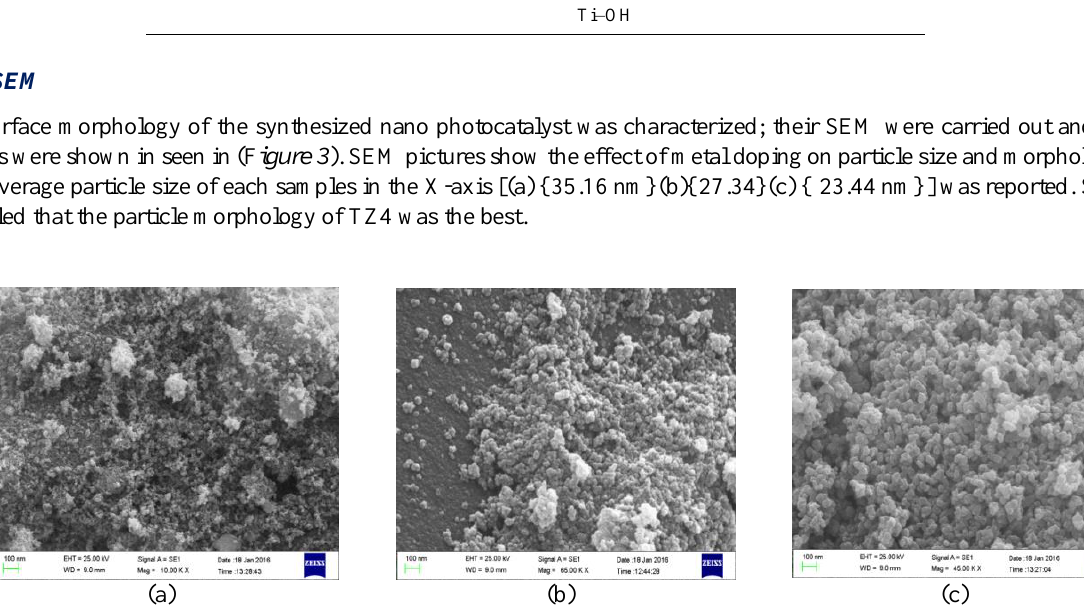
Figure 3. SEM images analysis of catalyst samples of nanocatalyst (a) T, (b) TZ2, (c)